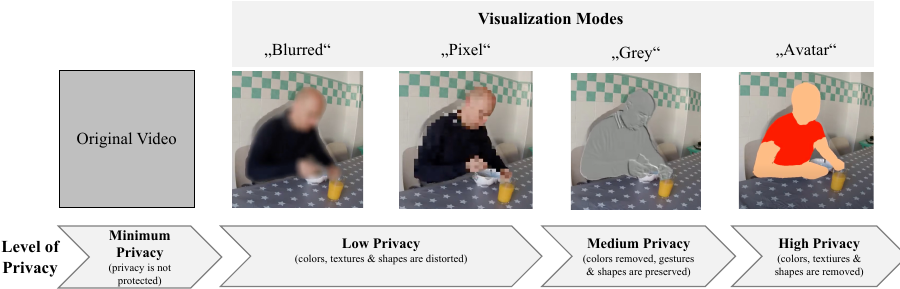
Figure 1. Overview of the visualization modes and their privacy level based on and adapted from [15]: video sequences recorded and provided for the study by F. Florez-Revuelta and P. Climent-Pérez (University of